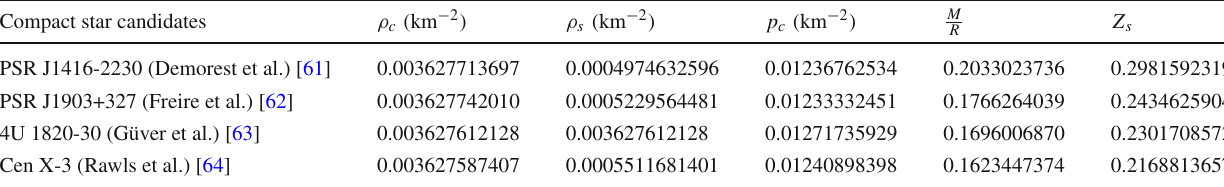
Table 2 Some physical parameters calculated for radii and mass for some compact star